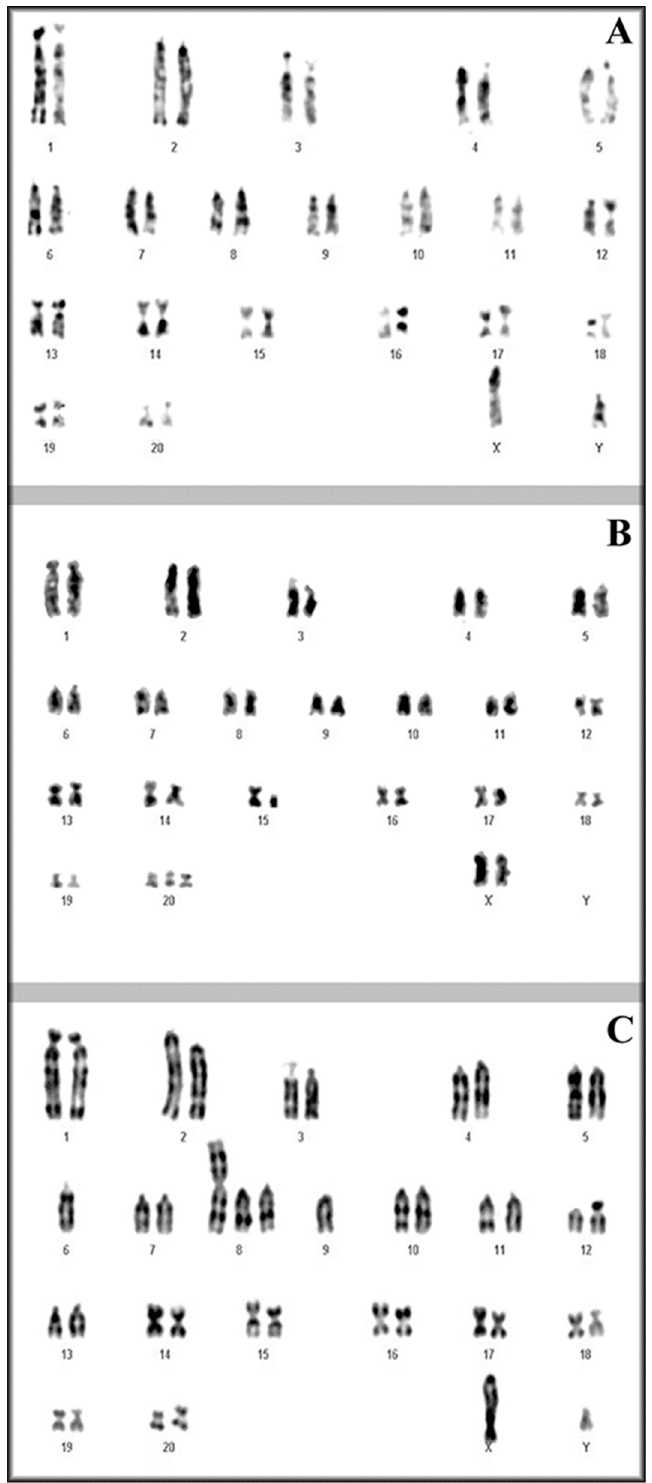
Figure 2. Representative karyotypes of ( A ) Primary astrocytes, ( B ) A-GS1, ( C ) A-FC6. In primary astrocytes no chromosome aberration is visible; in B, clonal aneuploidy was evidenced (e.g., trisomy #20); in C, both clonal aneuploidy and clonal chromosome aberration were present [e.g., monosomy #9 and i(8q)] .